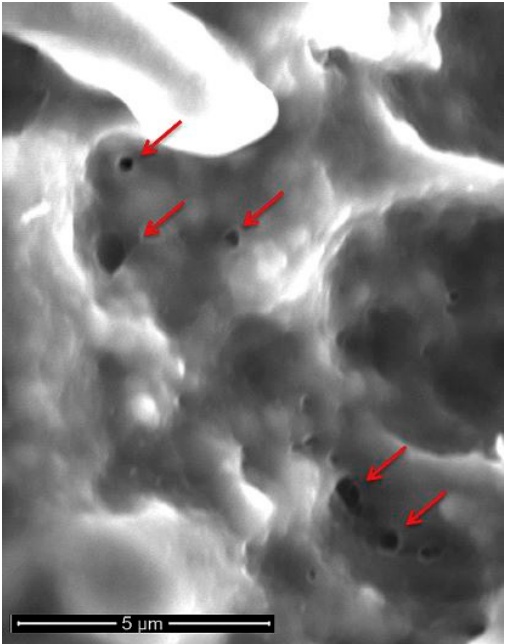
Figure 1. Scanning electron microscopy of irreversible electroporation (IRE)-ablated porcine liver. Nano-sized pores (red arrows) are visible on the cell membrane. Reproduced with permission from Jourabchi, N. et al., Gastrointestinal Interventions; published by Elsevier, B.V., 2014.